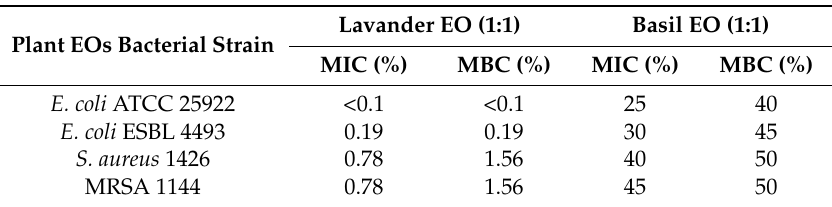
Table 5. Minimum inhibitory concentration (MIC) values and minimum bactericidal concentration (MBC) values determined based on conventional plating method for Plant EOs.